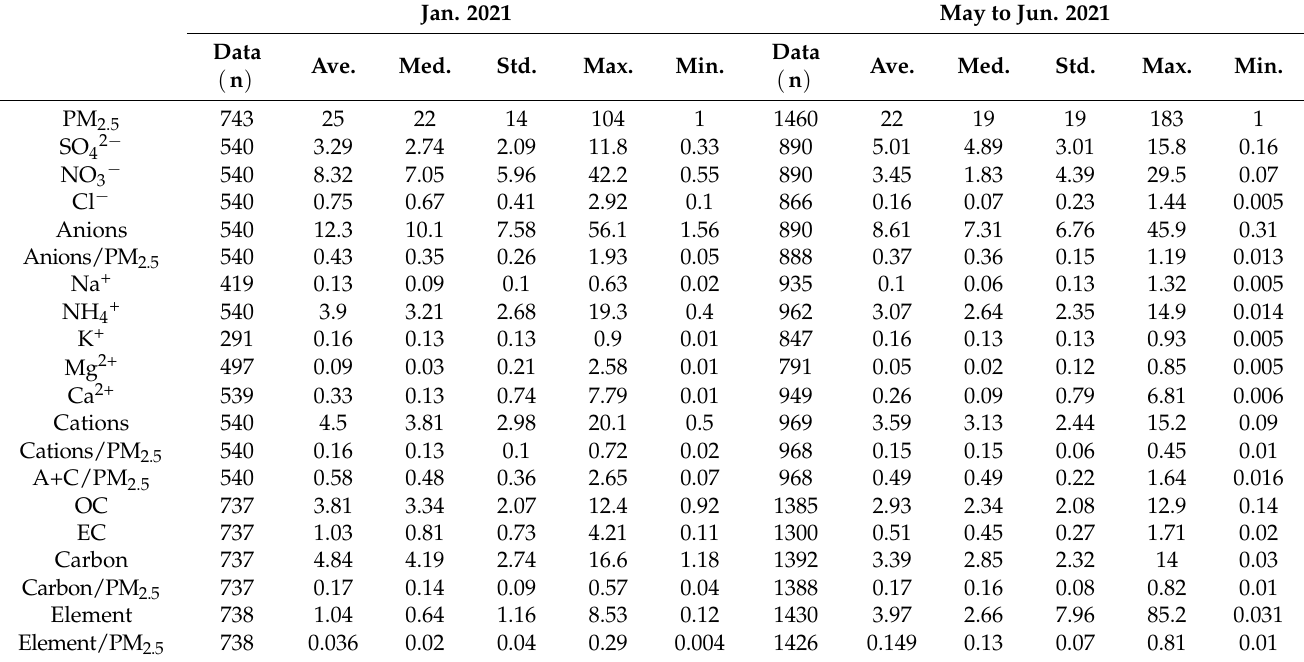
Table 1. PMF input data during the measurement period ( µ g/m 3